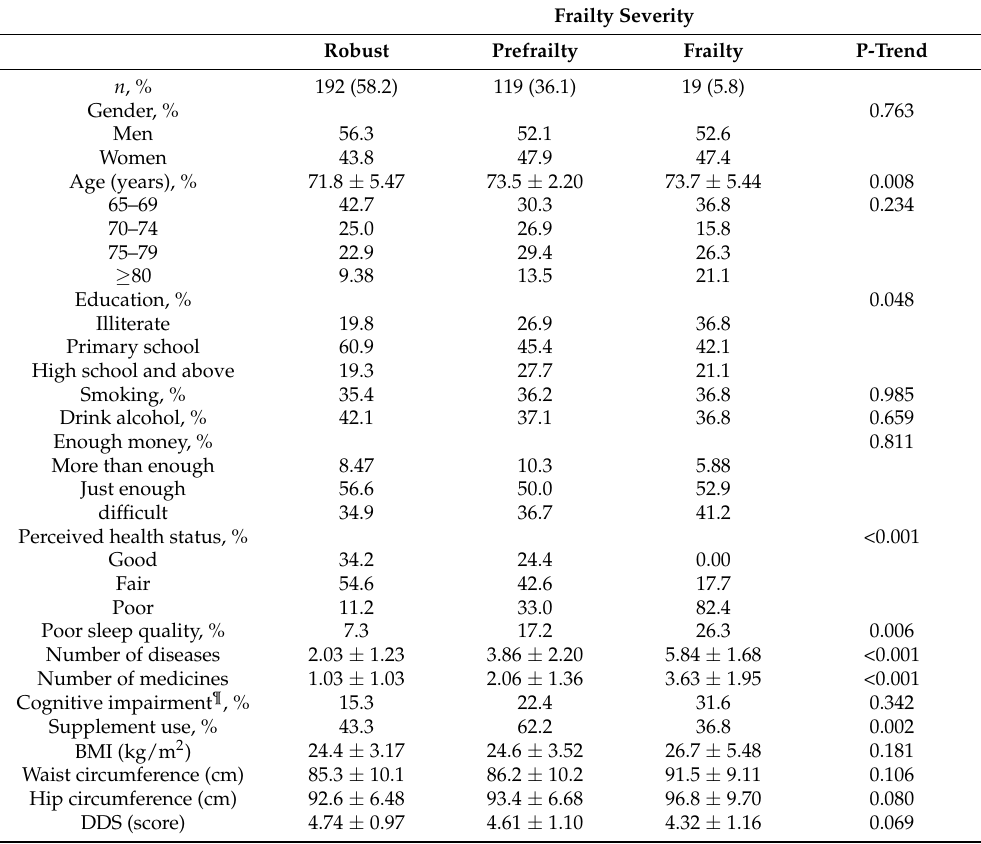
Table 1. Baseline characteristics by frailty severity among NAHSIT 2005–2008 older adults ( n =